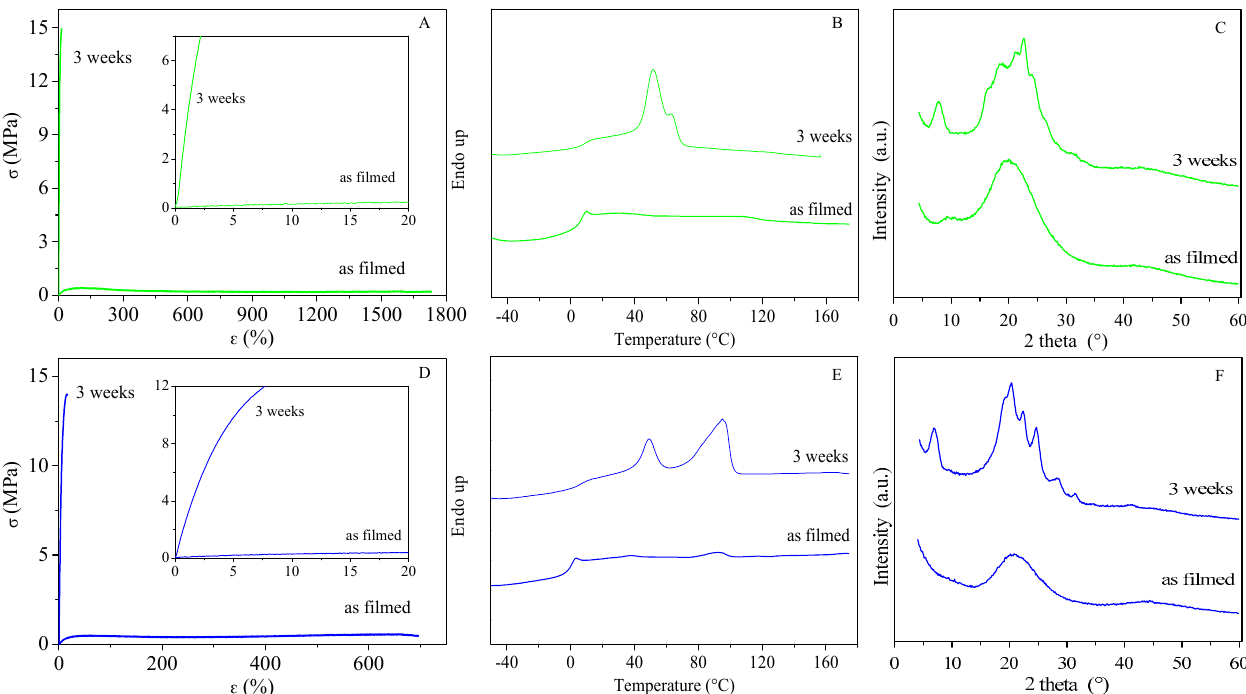
Figure 7. ( A ) Stress–strain curves; ( B ) DSC curves; ( C ) WAXS profiles of PPeTF films immediately after moulding and after 3 weeks of storage at room temperature. ( D ) Stress–strain curves; ( E ) DSC curves; ( F ) WAXS profiles of PHTF films immediately after moulding and after 3 weeks of storage at room temperature.